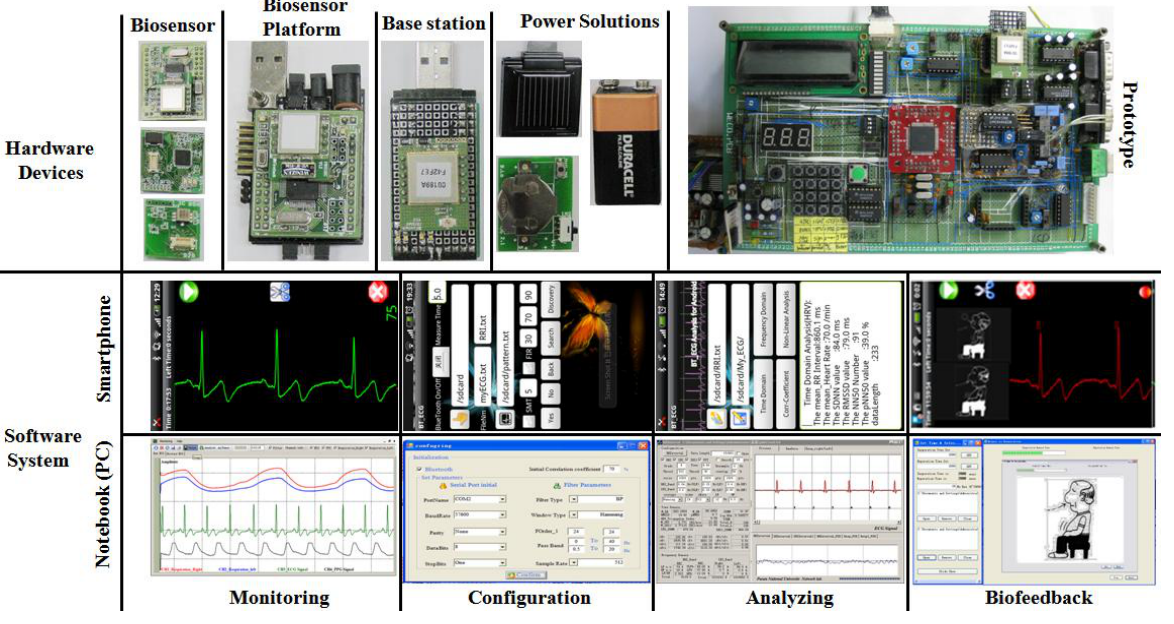
Figure 9. The implementations of the hardware devices (prototype and wearable) and software system (smartphone and